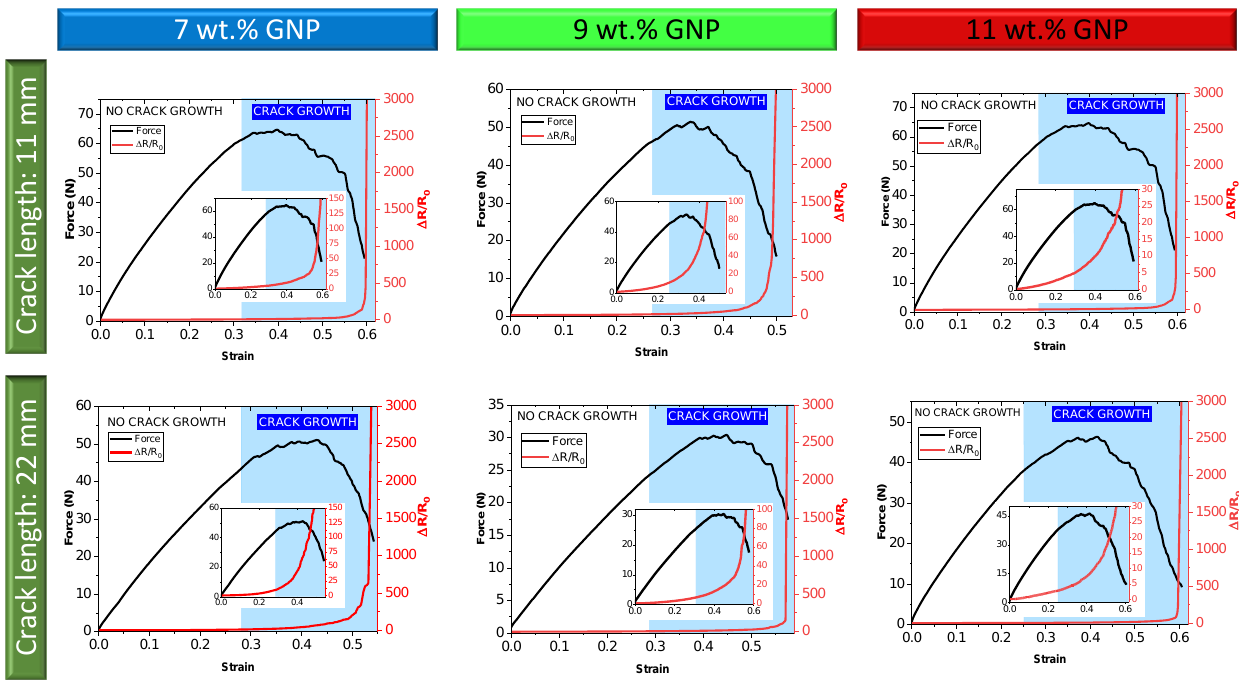
Figure 3. Electromechanical curves of the GNP-PDMS sensors under the crack-growth monitoring test. The inserted figures show a detail of the curves at lower strain levels to indicate the exponential behavior of the electrical response.